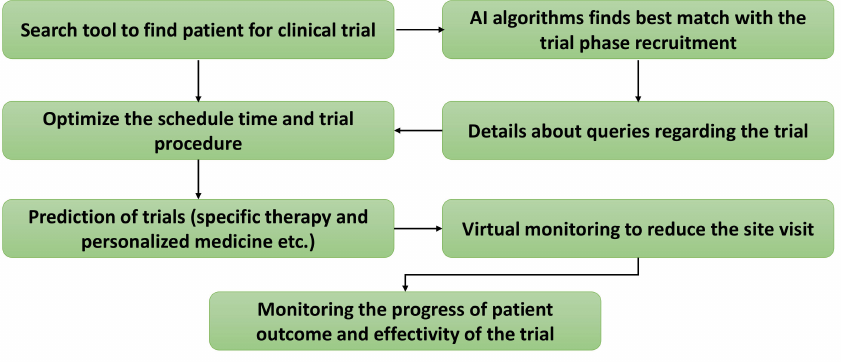
Figure 4. SML-empowered clinical trial procedure. AI = Artificial